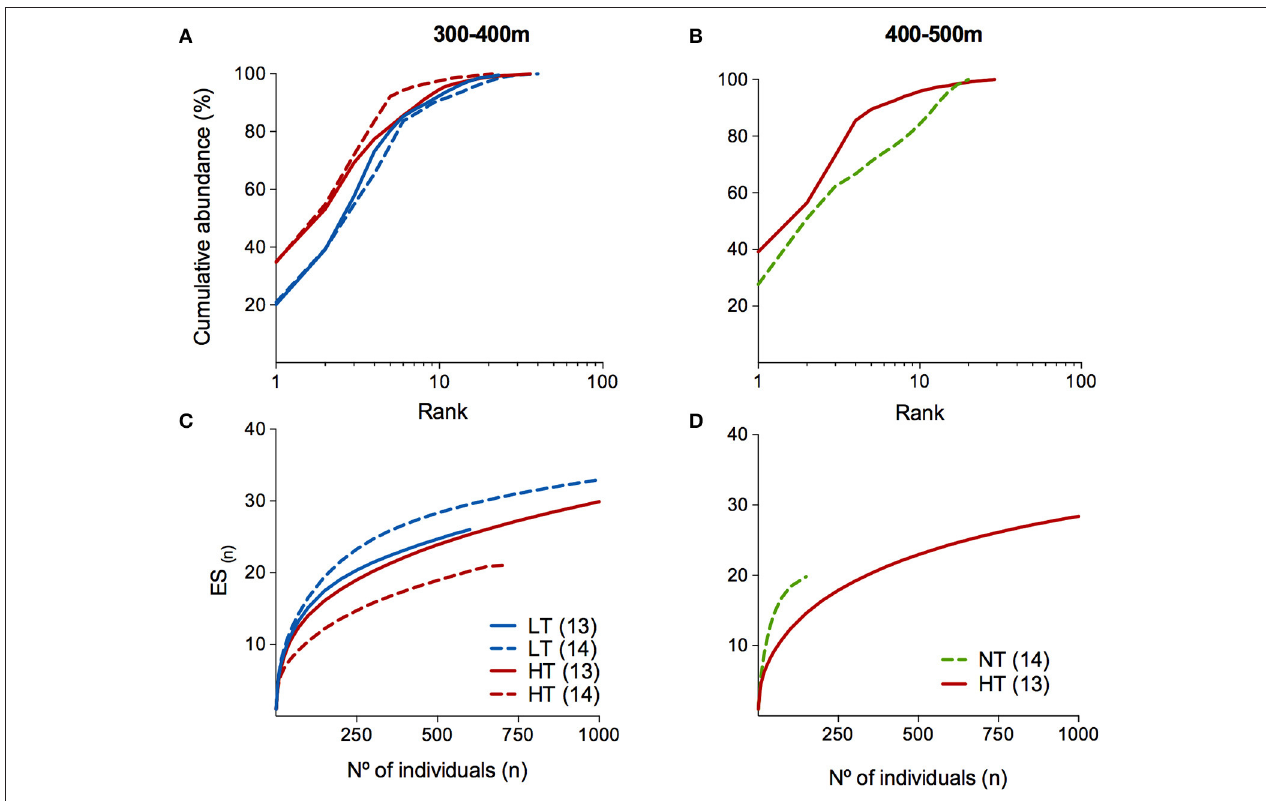
FIGURE 5 | Diversity comparison among the different disturbed areas through (A,B) k-dominance curves and (C,D) rarefaction curves (Hurlbert’s expected number of species) computed based on the selected dataset for mega-epibenthic assemblages at depth of 300–400m (Left) and 400–500m (Right) within muddy-sand sediments. NT, no trawling pressure; LT, low trawling pressure; HT, high trawling